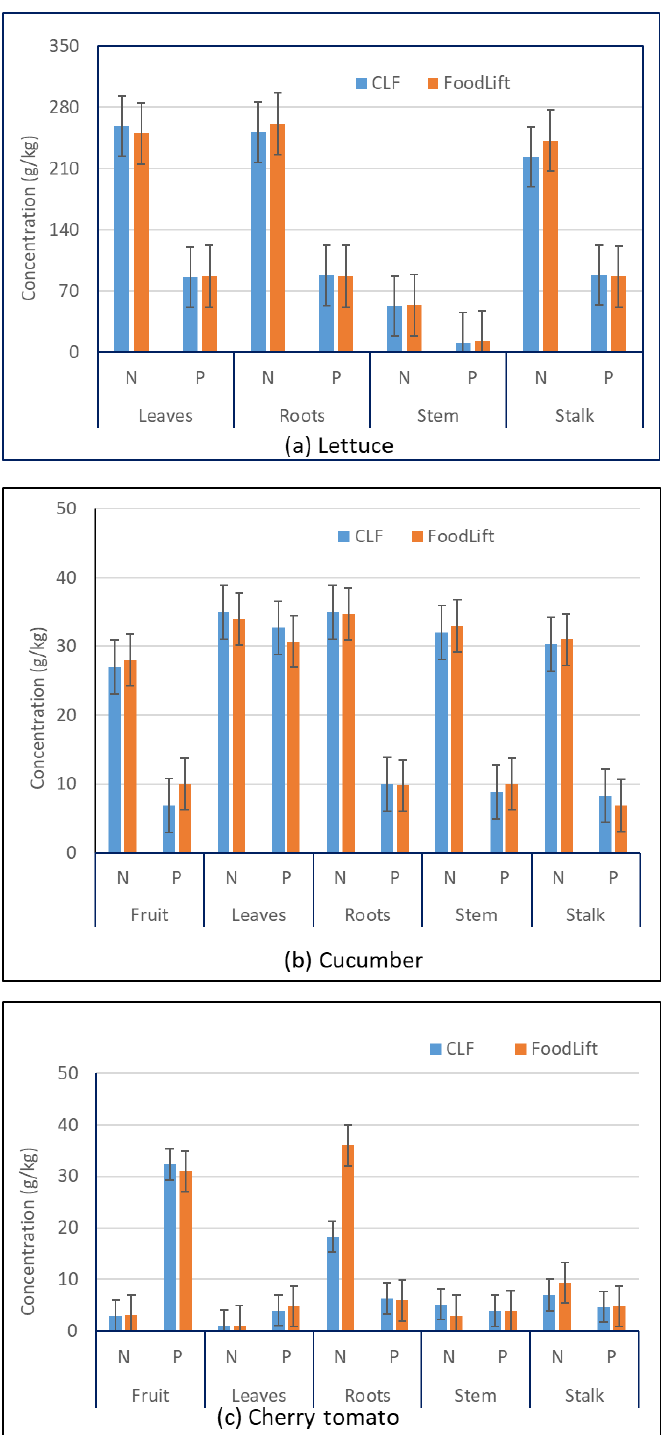
Figure 2. Nitrogen (N) and phosphorus (P) in parts of ( a ) lettuce, ( b ) cucumber, and ( c ) cherry tomato plants (error bars indicate standard deviation (SD)